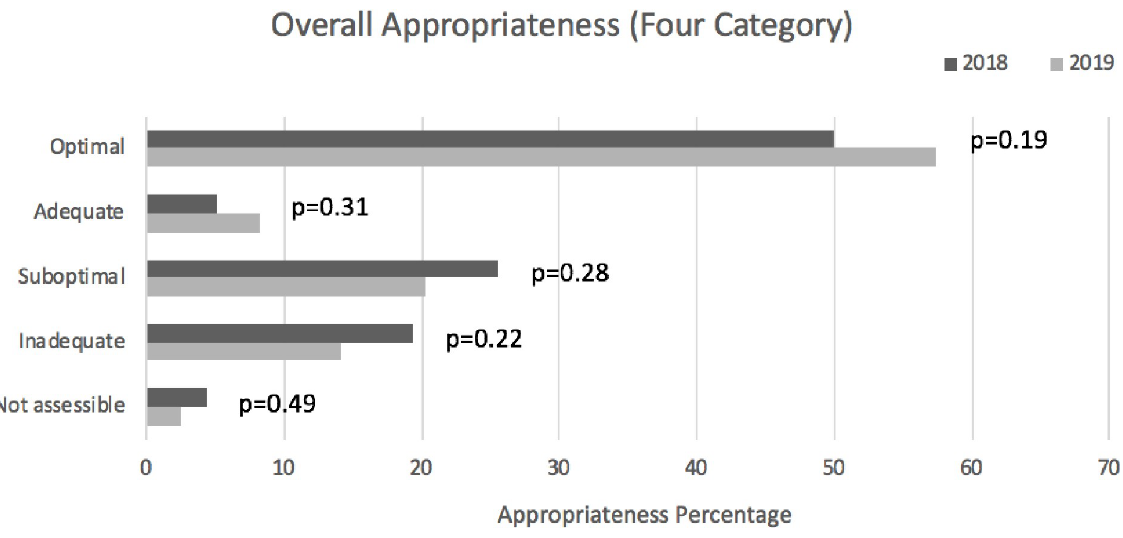
Fig 3. Antimicrobial prescribing appropriateness (Four category).